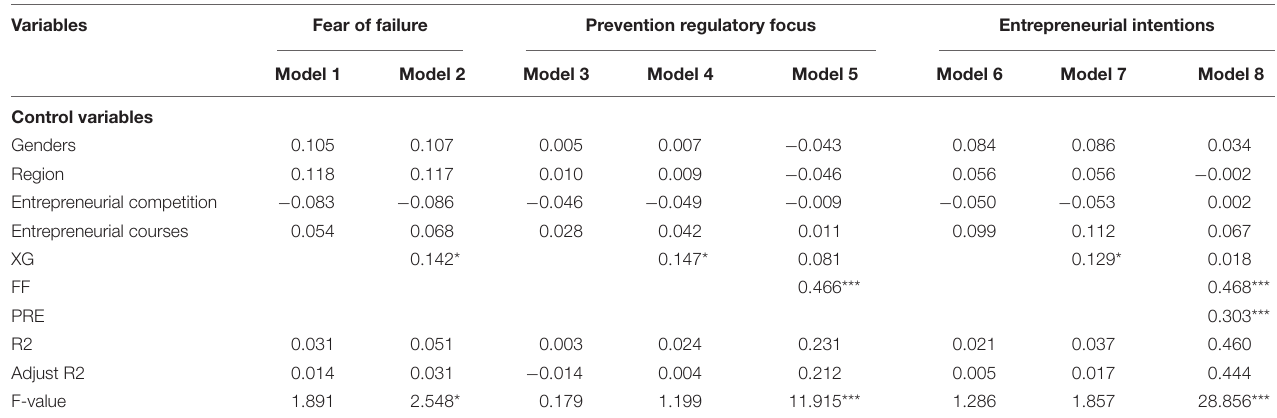
TABLE 4 | Regression analysis results (PRE path).